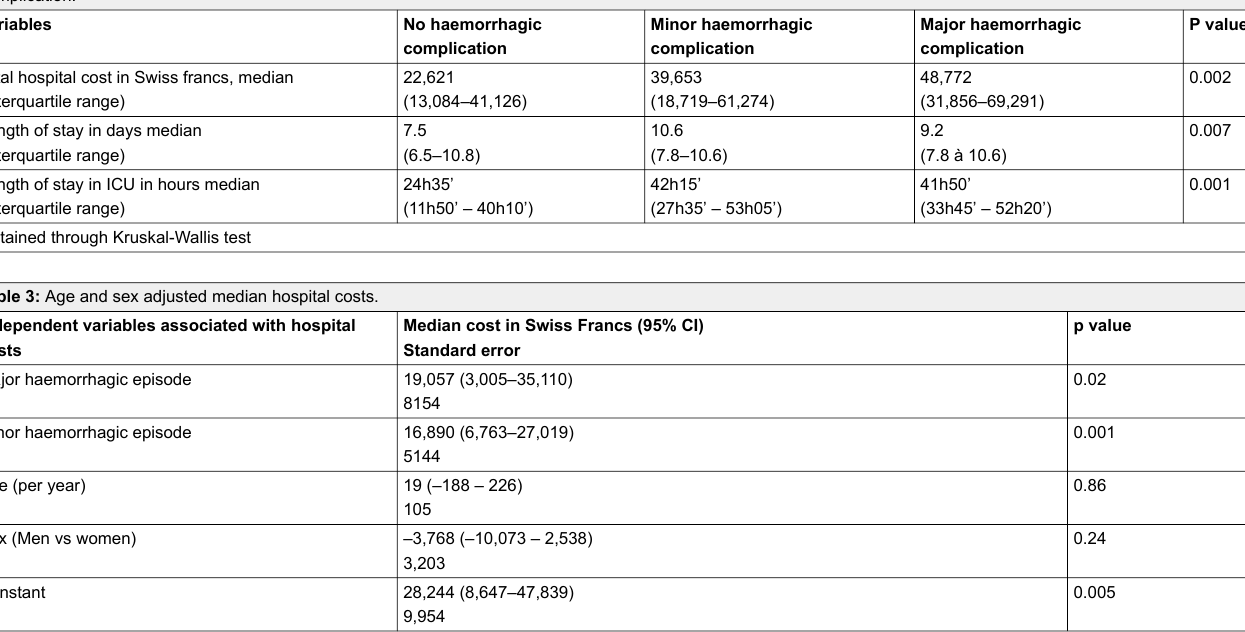
Table 2: Unadjusted total hospital cost, total hospital length of stay and intensive care unit length of stay according to the presence or the absence of haemorrhagic complication. Variables